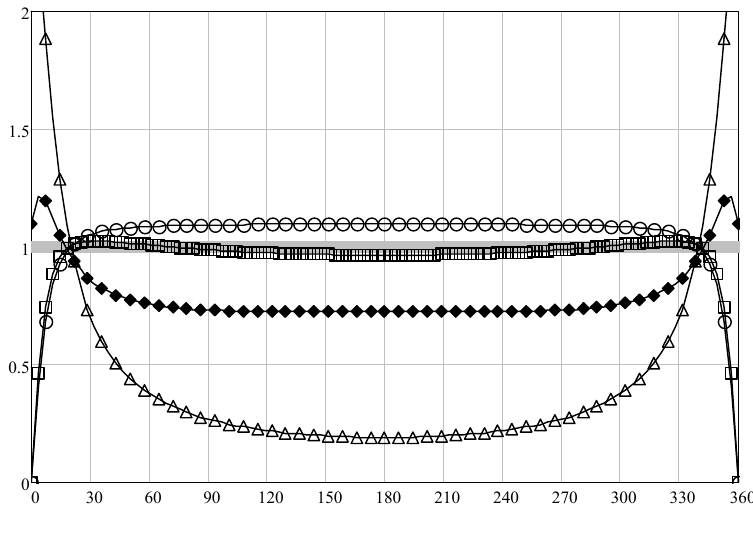
Figure 5. The ratios of the scattering diagram modules. The ratios of the scattering diagram (SD) modules for Х = 30, х ( Х ) = 0.076, and φ 0 = 160º are plotted along the vertical axis. Circles—GDC (9), triangles—PODC (10), squares— ah ( R , T , φ , φ 0 ) (11), and diamonds— ah 0 ( R , T , φ , φ 0 ) (14).